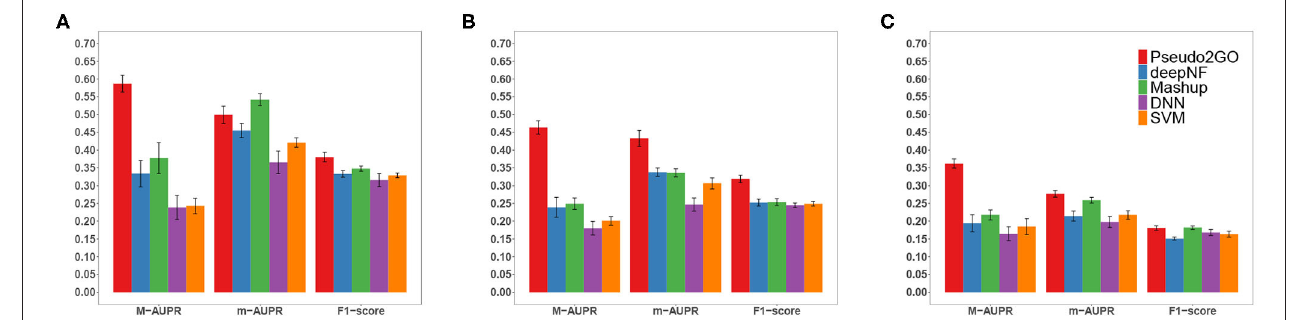
FIGURE 2 | Performance comparison of Pseudo2GO with other machine learning methods. Macro-AUPR, micro-AUPR and F1-score are used for evaluating the performance. Panels (A–C) show the comparison results on CC, MF and BP ontology, respectively. Each method is evaluated using 5-fold cross-validation, repeated 10 times to calculate the confidence